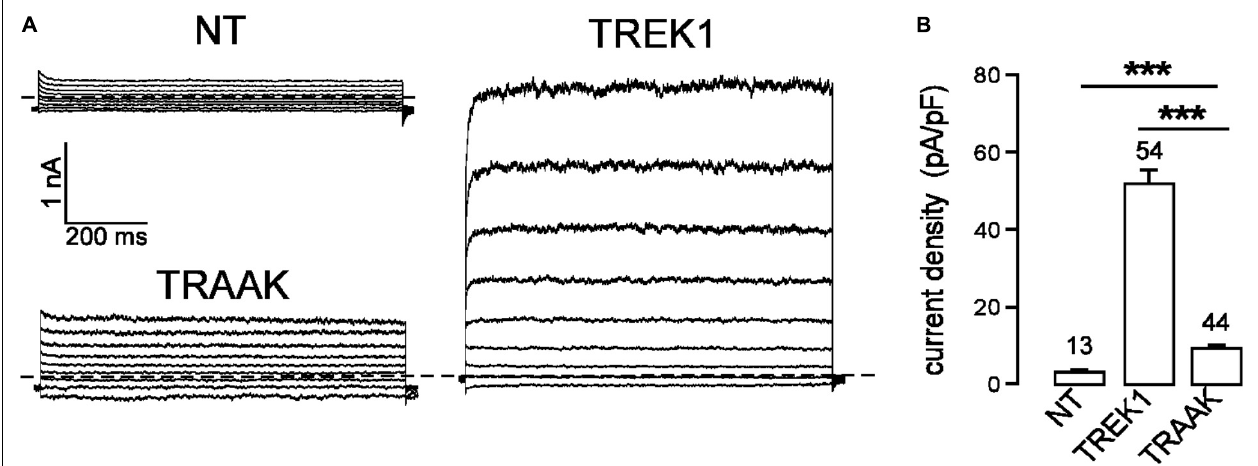
FIGURE 1 | TREK1 and TRAAK currents in HEK293 cells. (A) Representative whole-cell currents from non-transfected cells (NT) and cells transfected with TREK1 and TRAAK channels. Voltage steps were applied from –100 to 60 mV in 20 mV increments from a holding potential of –80 mV. The dotted lines indicate zero current. (B) Current densities at 0 mV. Data are presented as mean ± SEM. ∗∗∗ p < 0.001, the number of cells is indicated (Student’s t